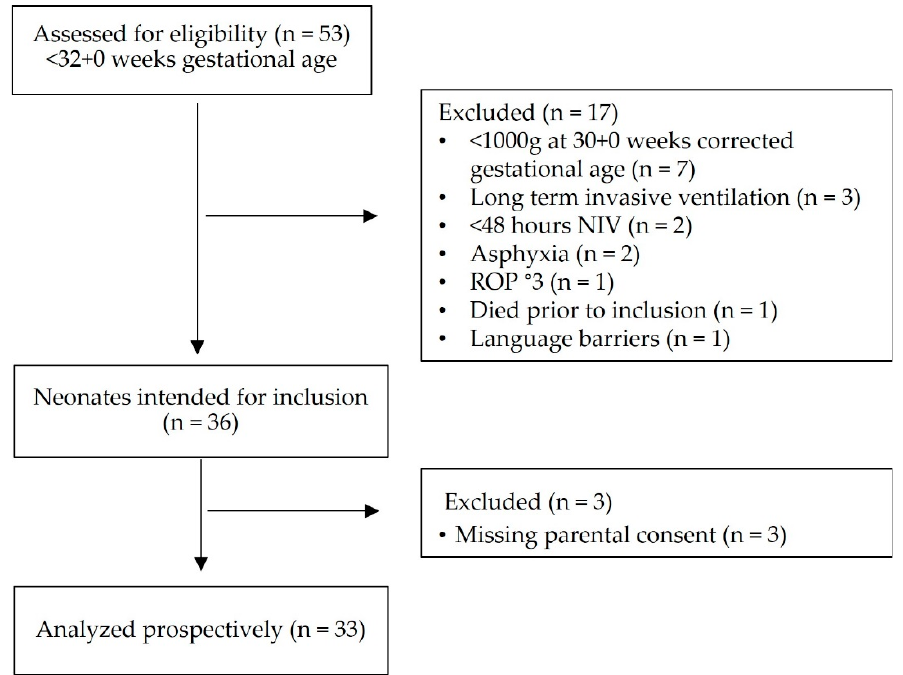
Figure 1. Consort flow diagram of prospective patient recruitment. Table 1. Baseline characteristics and different NIV modes in the study groups.